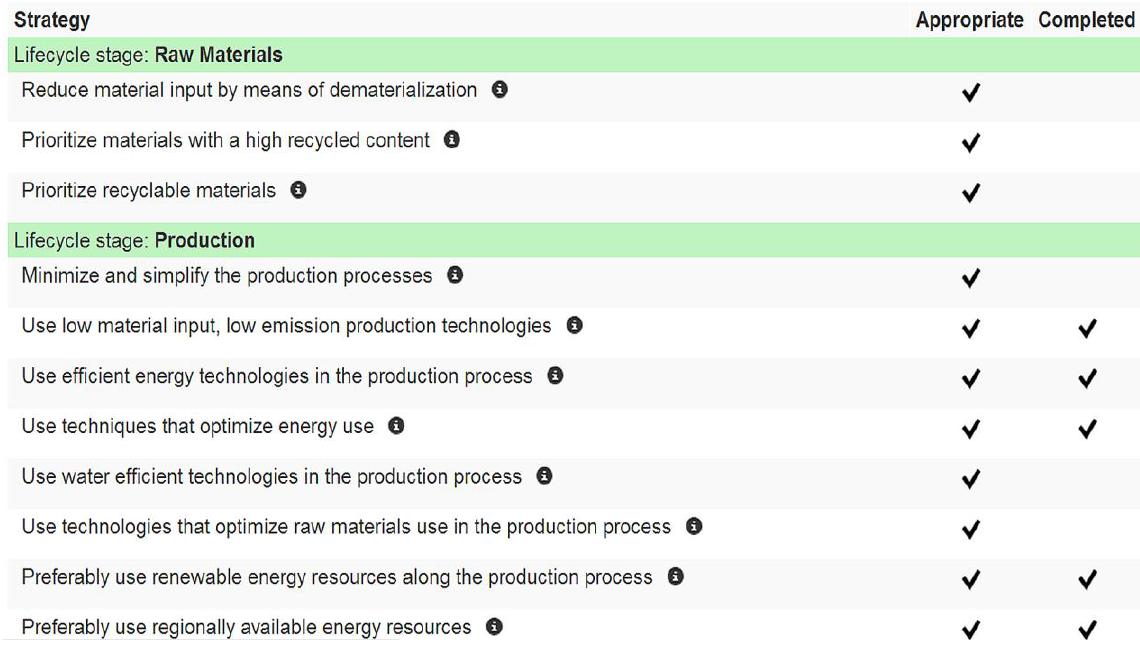
Figure 6. Assessment of the viability of potential strategies and selection of those to be included in the Action